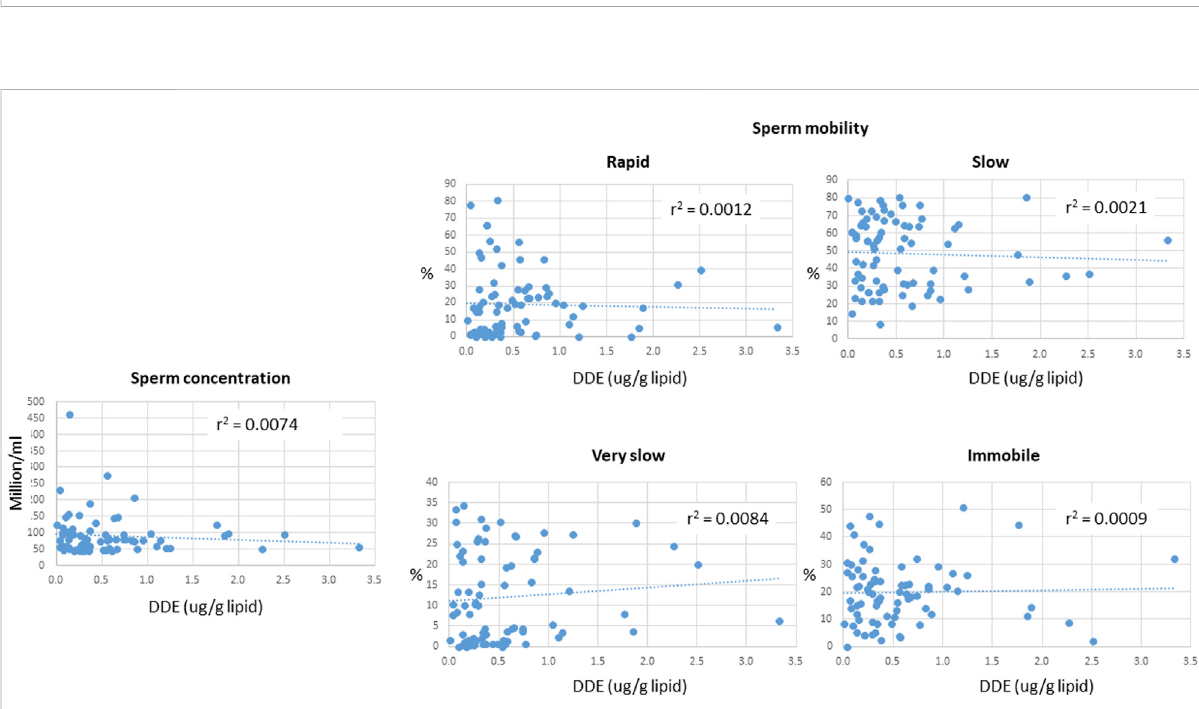
FIGURE 4 Relationship between serum concentrations of DDE and various sperm parameters, including sperm concentration and mobility. The motility terms “ rapid ” , “ slow ” , “ very slow ” , and “ immobile ” refer to the ability of sperm to move ef fi ciently (which is required to reach an egg and achieve fertilization). The graphs show the % of sperm in each sample that exhibit the indicated motility as a function of DDE levels in